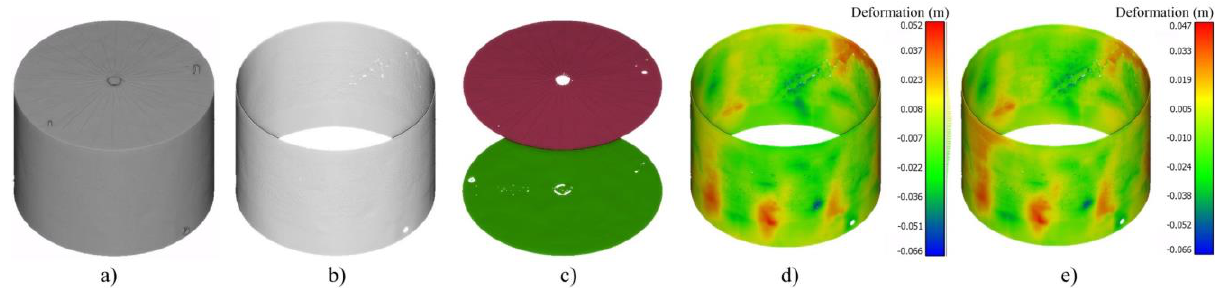
Figure 5 . Extracting components of a tank and estimating deformation of a shell wall a) Point clouds; b) data points of a shell wall; c) data points of a roof and floor; d) and e) resulting deformation of the shell wall based